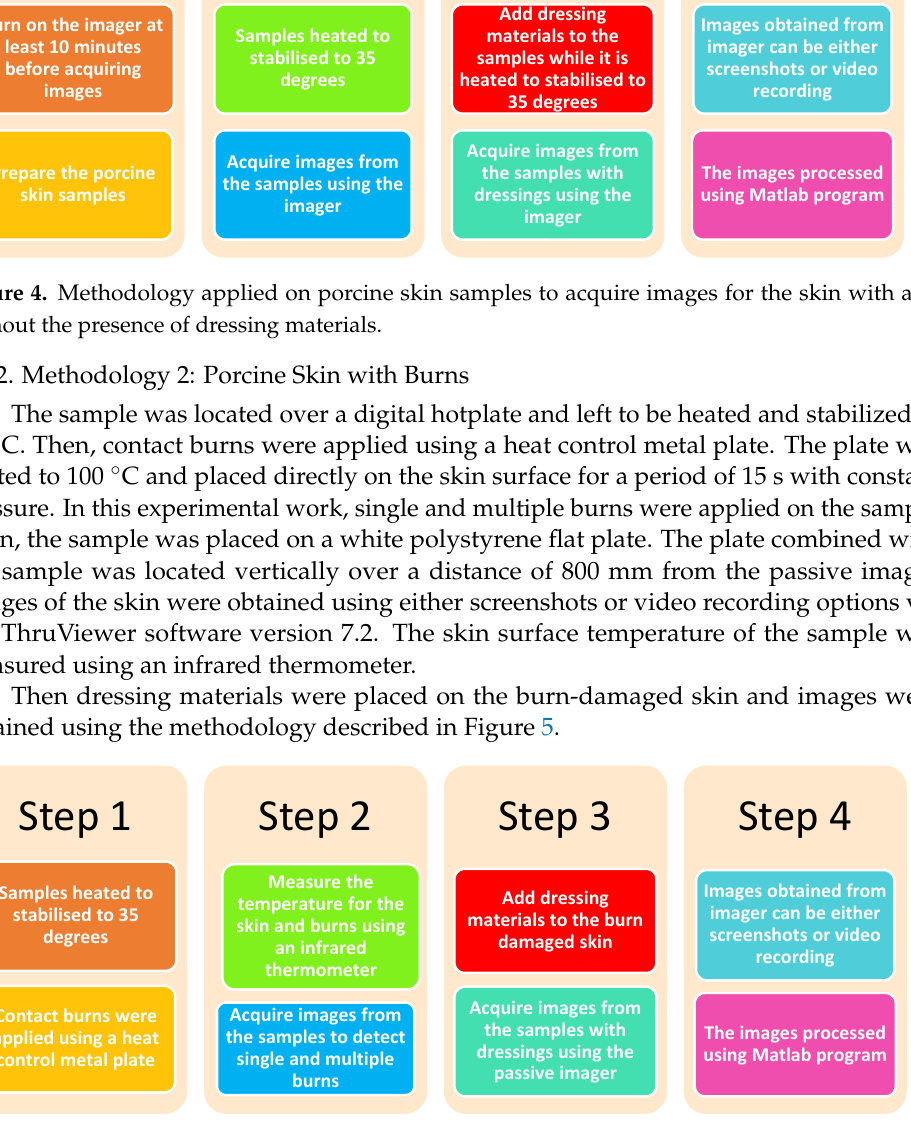
Figure 5. Methodology applied on burned skin samples to acquire images for the burned skin with and without the presence of dressing materials.